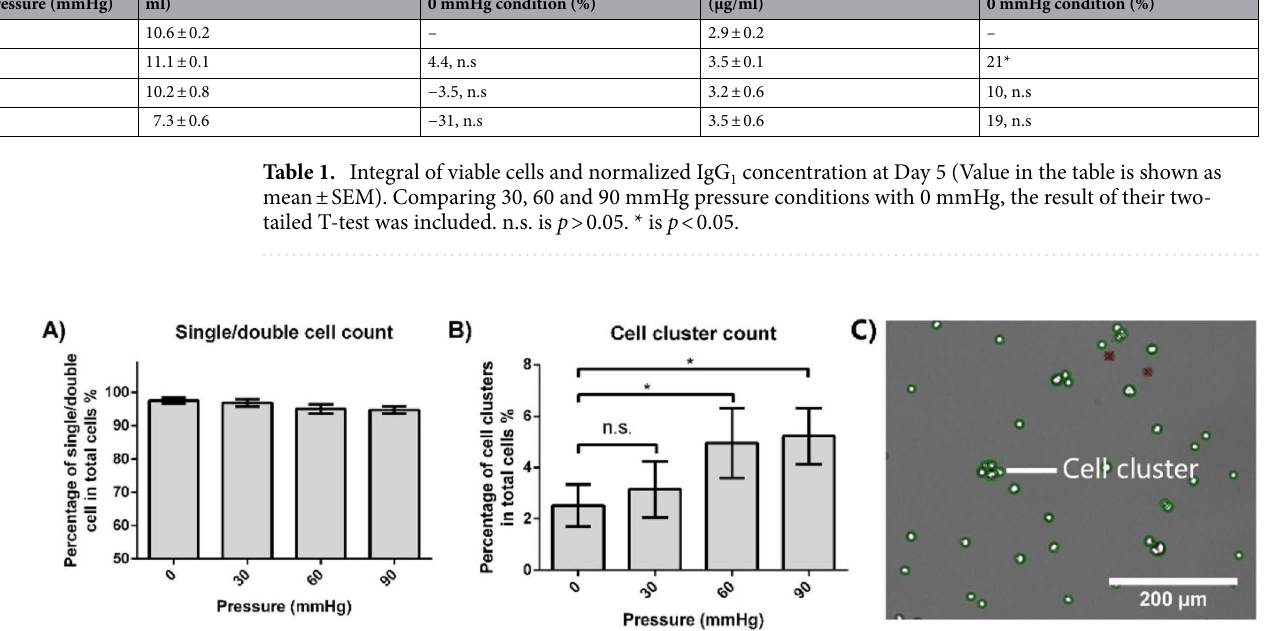
Figure 5. Percentage of cell cluster formation on Day 5. ( A ) The proportion of single and double cells under different pressure conditions. ( B ) Proportion of cell clusters under different pressure conditions. ( C ) Representative image from the cell culture analyzer. Green circles indicate viable cells, and red crosses indicate dead cells based on Trypan blue exclusion. ( n = 3) *Denotes statistical significance ( p < 0.05). “n.s.” denotes no statistically significant difference ( p >